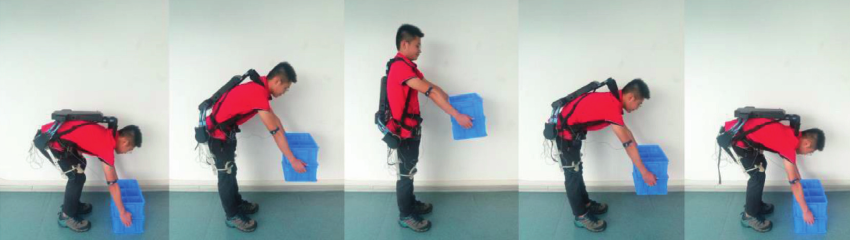
Figure 10: The process of a wearer lifting.